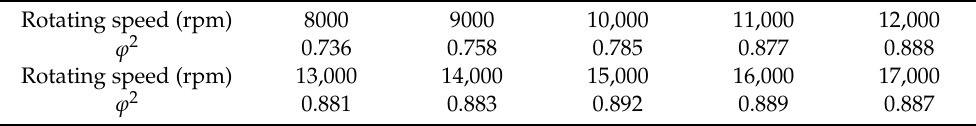
Table 7. Pressurization coefficient of the liquid-sealing